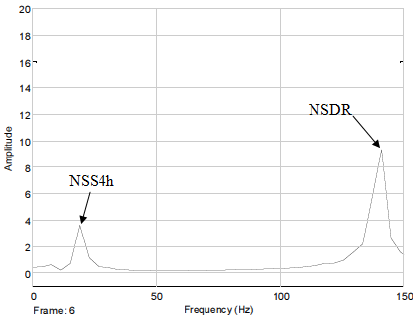
Figure 19. Frequency analysis of position signal prior to second order NSS filtering .